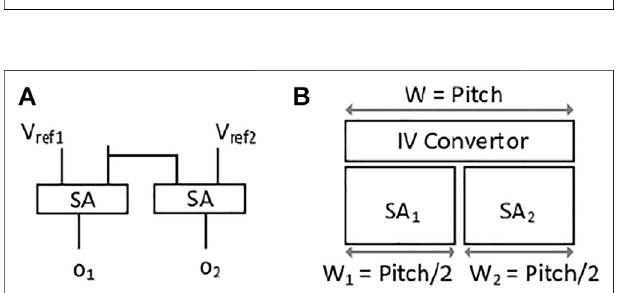
FIGURE 4 | Serial read model for ternary memory.